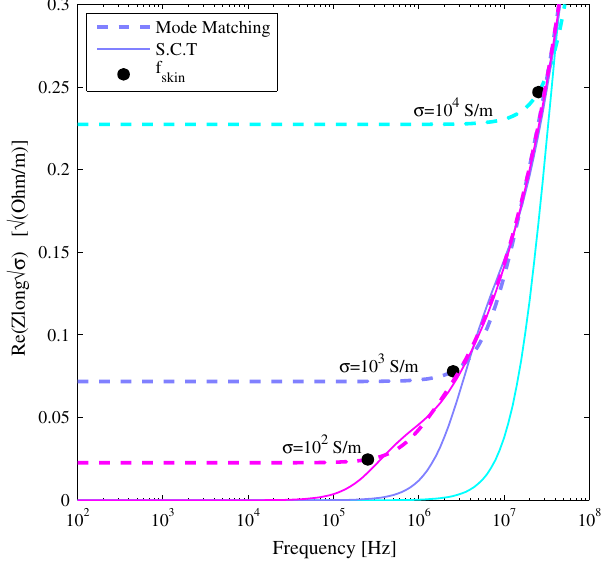
FIG. 10 (color online). Comparison of mode matching (thick lines) and SCT ’ s model (dashed lines). Curves with the same color refer to the same conductivity value. The black marks show the frequency f in which the skin depth approaches the cavity skin radius. Geometry: b ¼ 7 cm, t ¼ 1 cm, L ¼ 1 cm. Mode match- ing parameters: S ¼ 5 , P ¼ 5